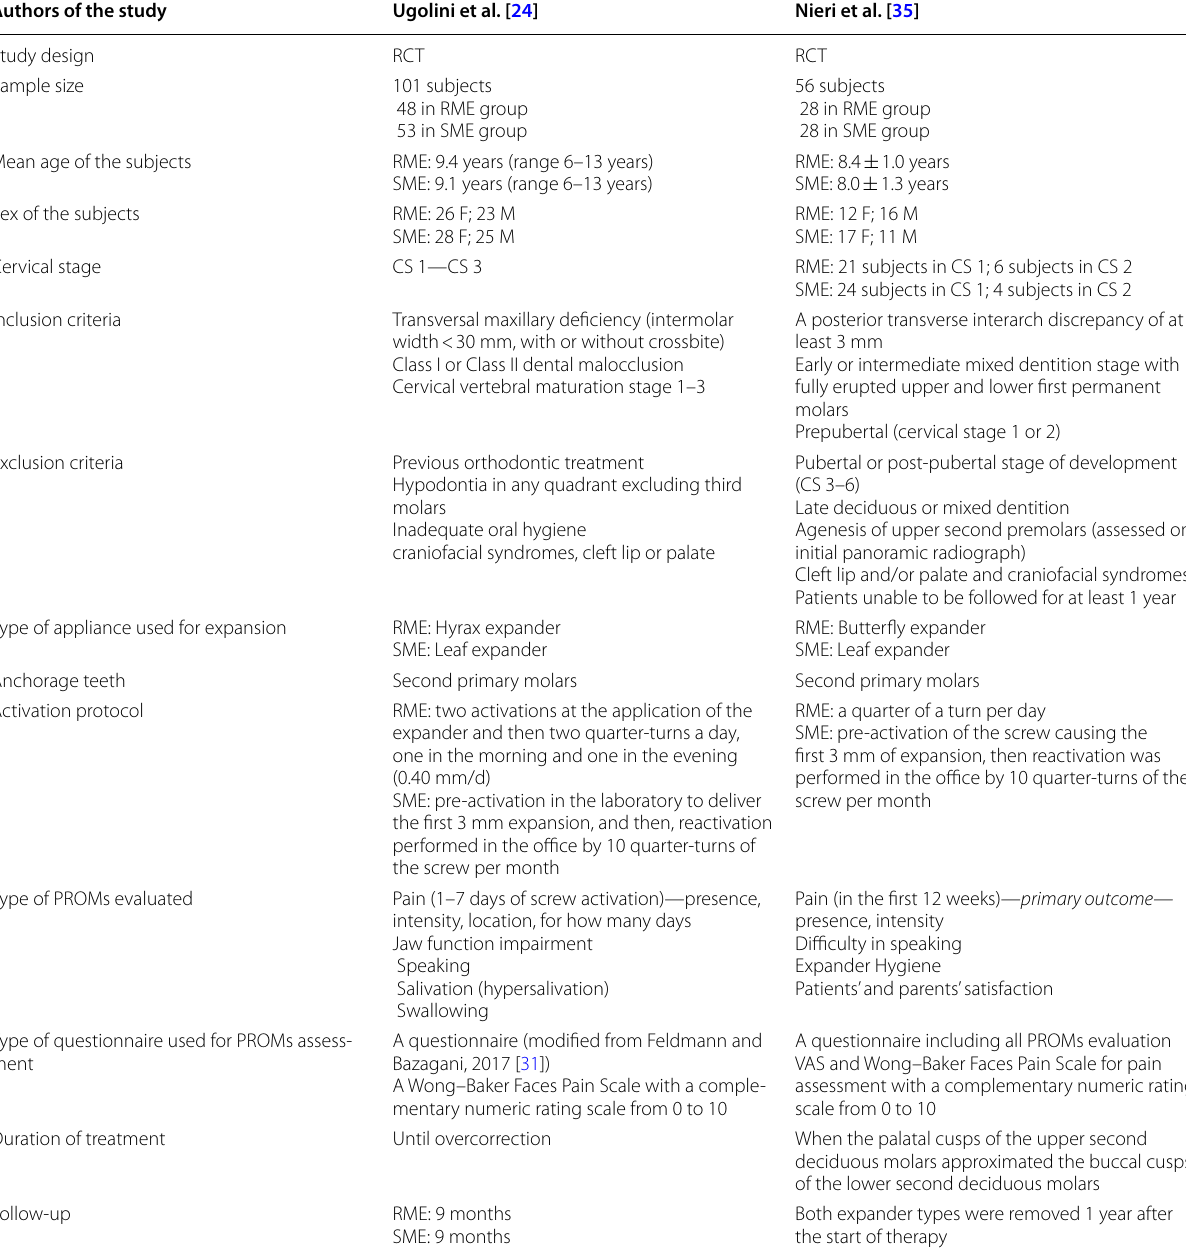
Table 4 Characteristics of included